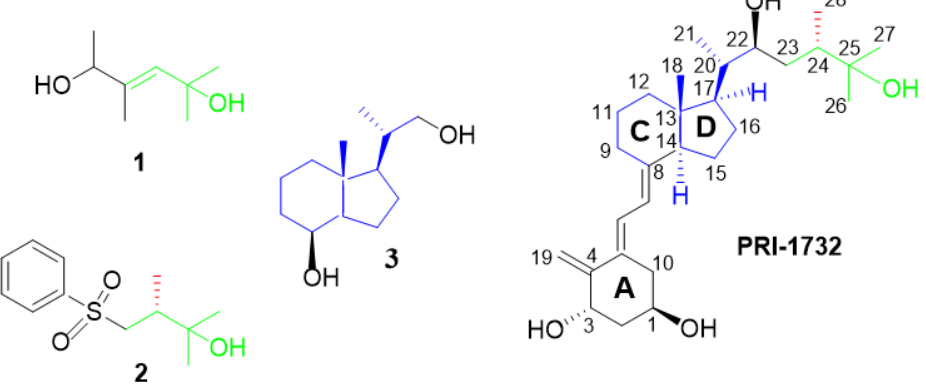
Figure 1. Structures of the vitamin D intermediates 1 , 2 , and 3 . The respective structural fragments of vitamin D are marked by colour and presented as an example final product (PRI-1732) with the distinctive numbering system of the vitamins D.